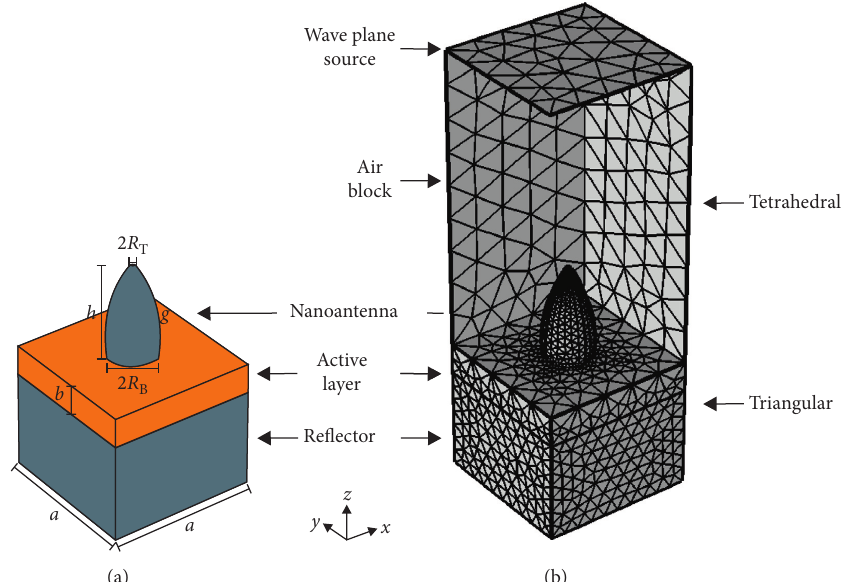
Figure 1: (a) Schematic diagram of the OSC with the CNV nanoantenna [7] and (b) OSC font and mesh